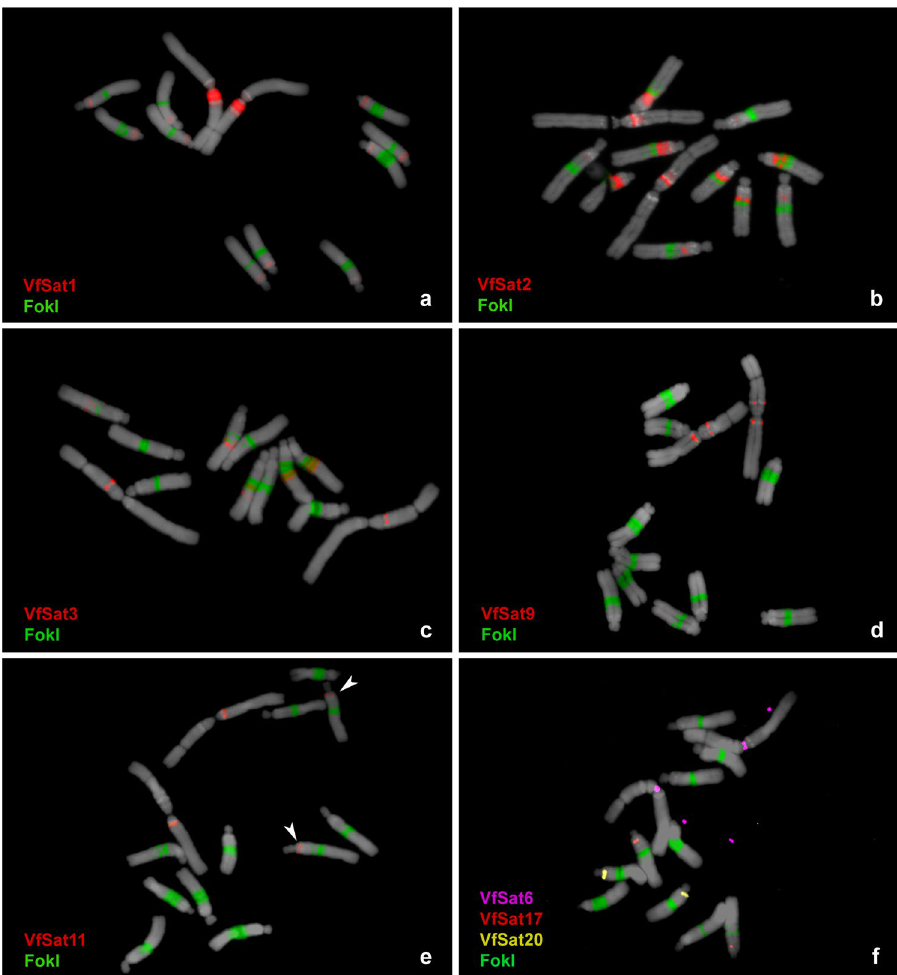
Figure 1. Distribution of selected satellite repeat families on metaphase chromosomes of Vicia faba . Satellites were visualized using multi-color FISH, with individual probes labeled as indicated by color-coded descriptions. Hybridization patterns of FokI repeats (green signals) were used for chromosome discrimination as shown in Supplementary Fig. S3. Chromosomes counterstained with DAPI are shown in gray. Arrowheads in ( e ) point to polymorphic VfSat11 signals on chromosome 2 (see Fig. 3b for comparison).